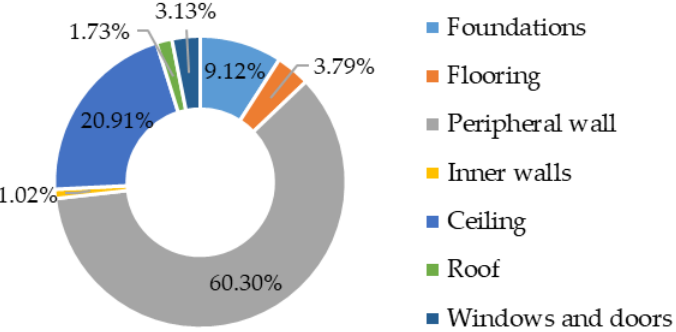
Figure 10. Impact distribution of construction components on water scarcity.